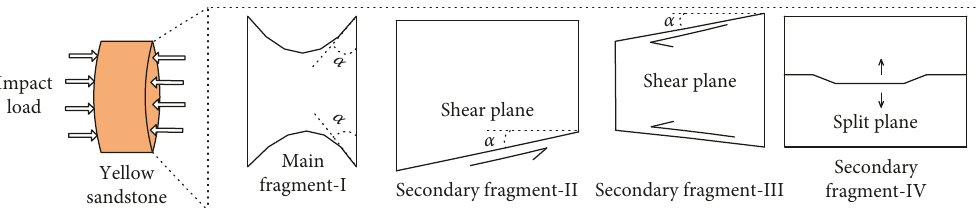
Figure 14: Typical cross-section morphology of yellow sandstone after impact fracture. Fragment I, double-cone-failure; fragment II, single- side slope failure; fragment III, double-side slope failure; fragment IV, split